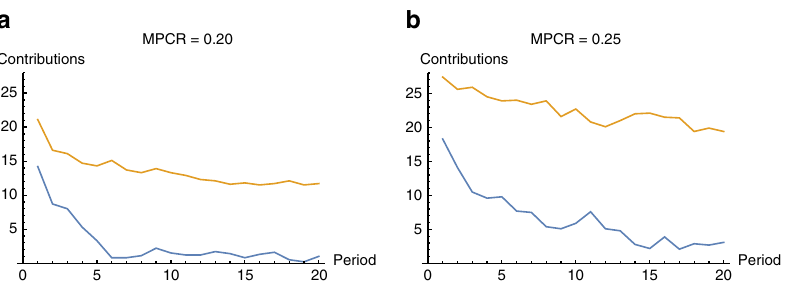
Fig. 1 Time series of mean aggregate group contributions per round. a MPCR = 0.2, P20 treatment with punishment ( orange ), N20 without punishment ( blue ); b MPCR = 0.25, P25 treatment with punishment ( orange ), N25 without punishment ( blue ). (N20, n = 15, P20, n = 15; N25, n = 14; P25, n = 14)